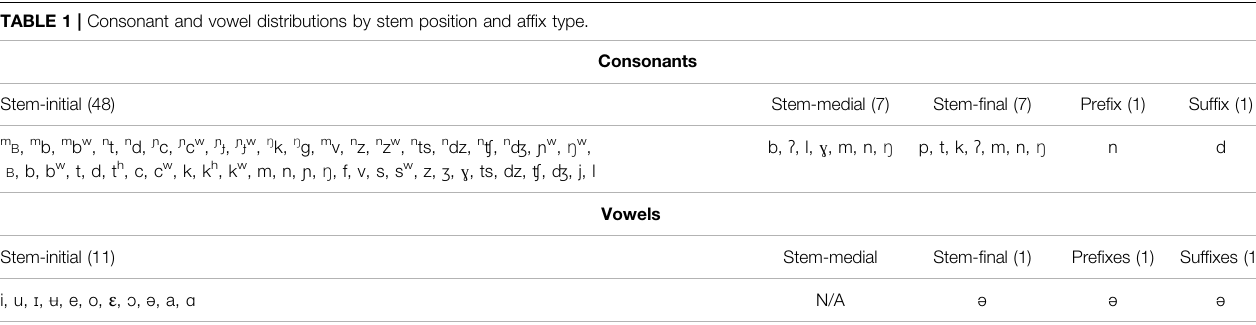
TABLE 1 | Consonant and vowel distributions by stem position and af fi x